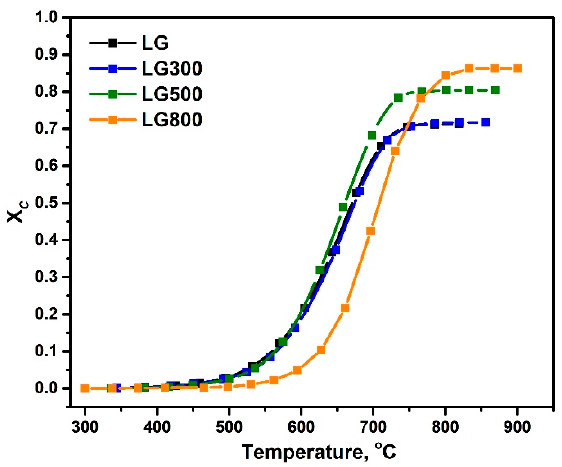
Figure 8. Effect of temperature on carbon conversion for raw lignite and chars during non-isothermal CO 2 gasification. Fuel: 100 mg, Flowrate: 30 cm 3 /min.